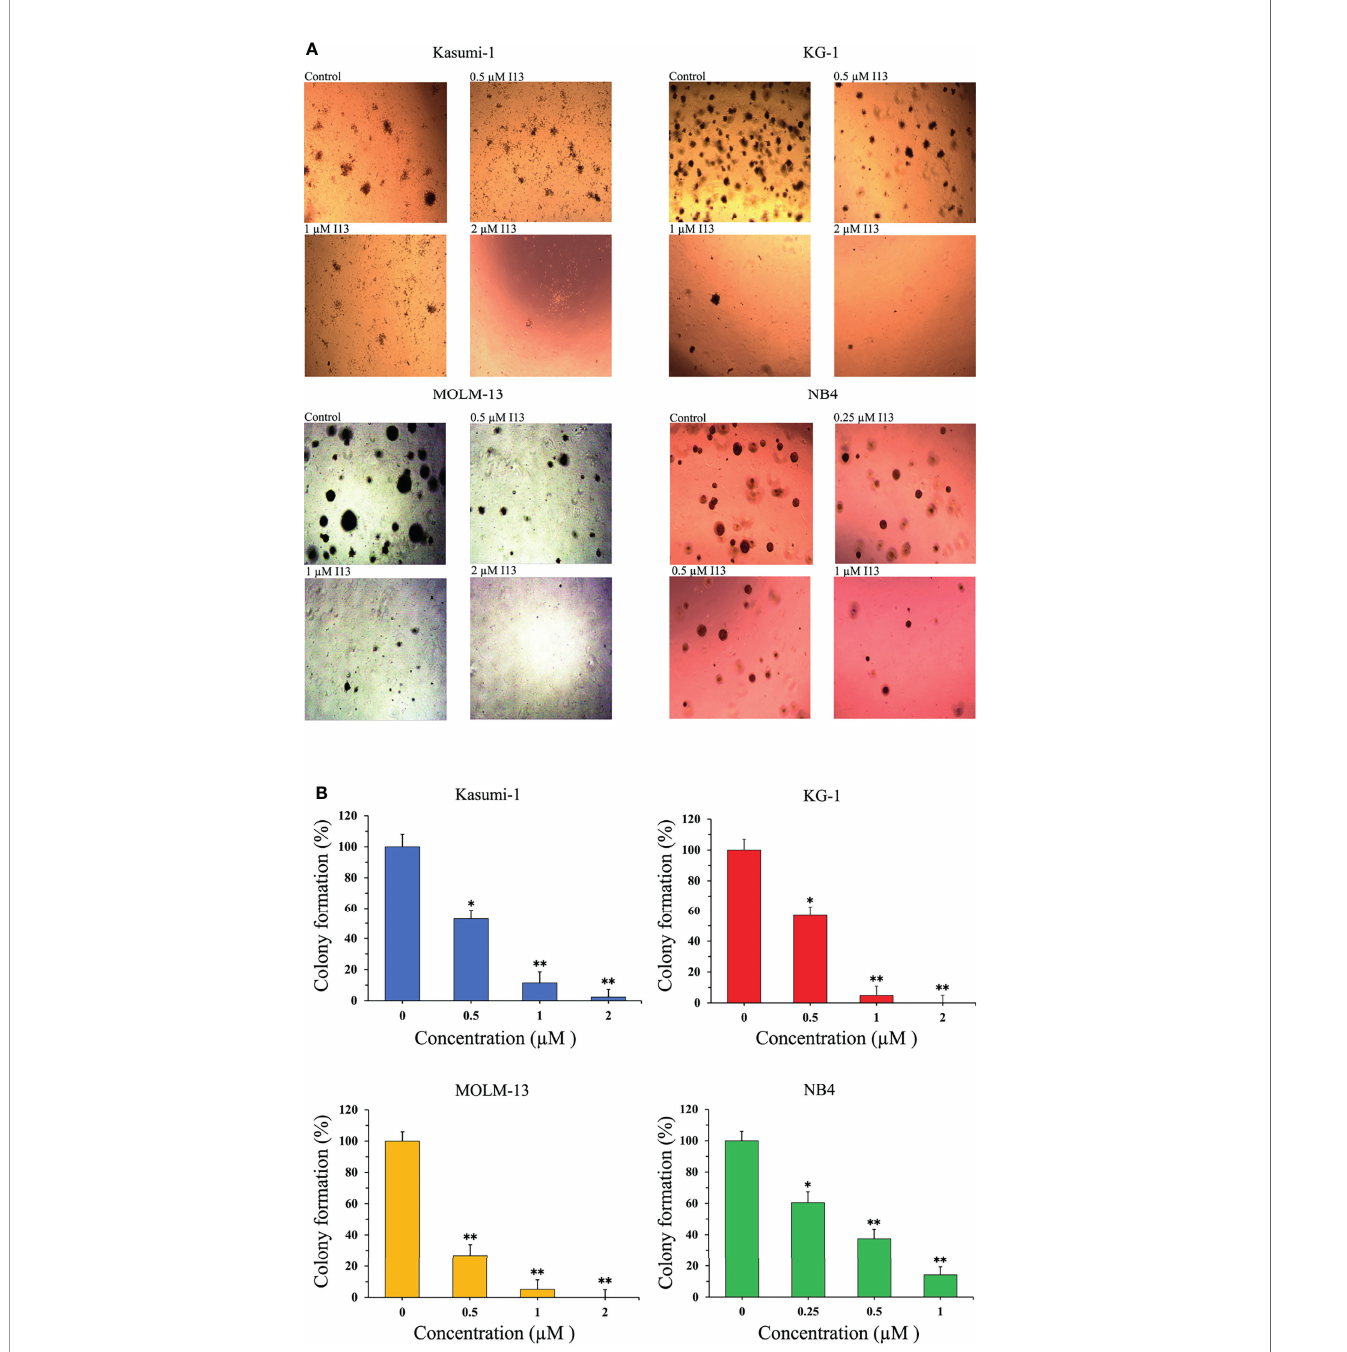
FIGURE 2 | I13 reduced the colony-forming ef fi ciency of Kasumi-1, KG-1, MOLM-13 and NB4 cells. (A) Kasumi-1, KG-1, MOLM-13 and NB4 cells were incubated with I13 (0.25 – 2 µM) for 15 days and examined with light microscopy. (B) A bar graph showing the statistical analysis of colony-formation number (*p < 0.05 and **p < 0.01). The analysis was performed three